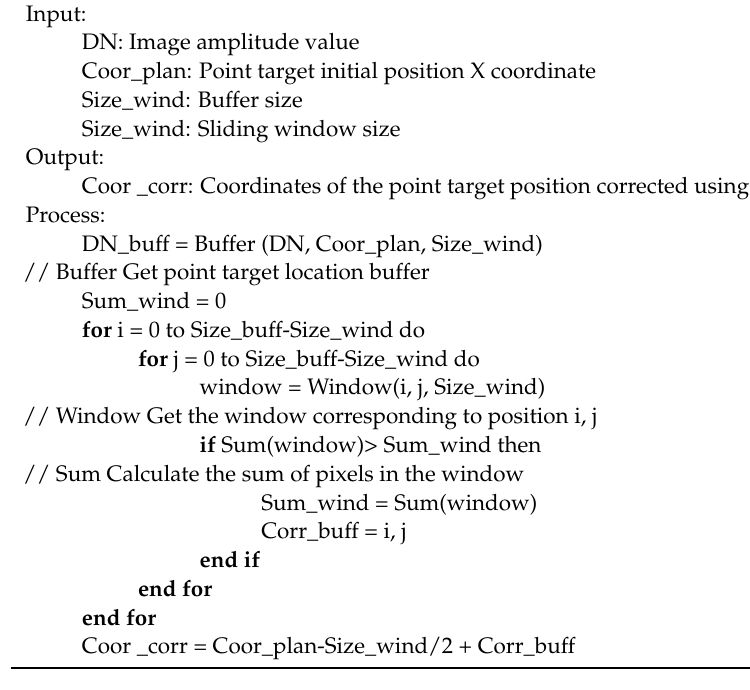
Algorithm 1: Sliding window method point target center location extraction process.